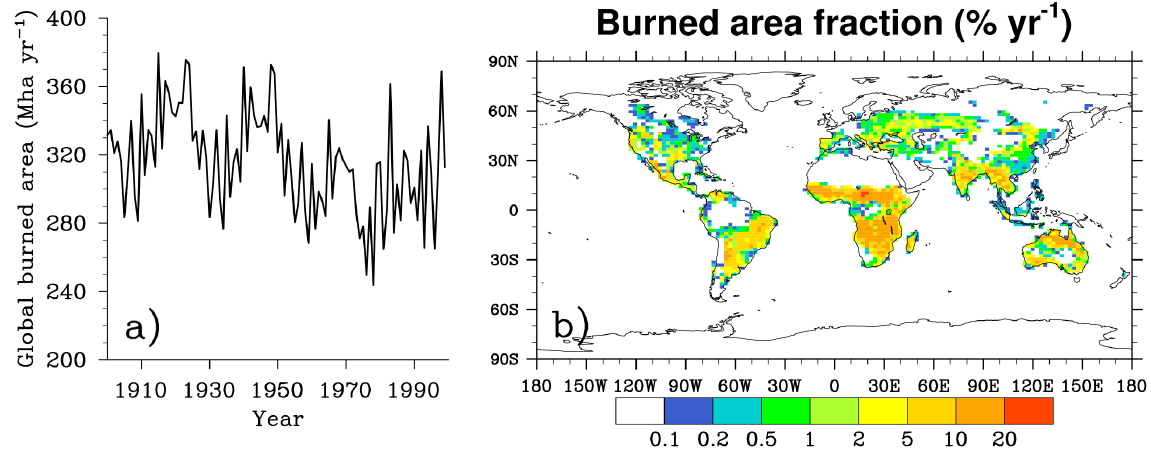
Fig. 1. (a) 1900–1999 historical variability of global total of annual burned areas and (b) global spatial distribution of 1900–1999 average annual burned area